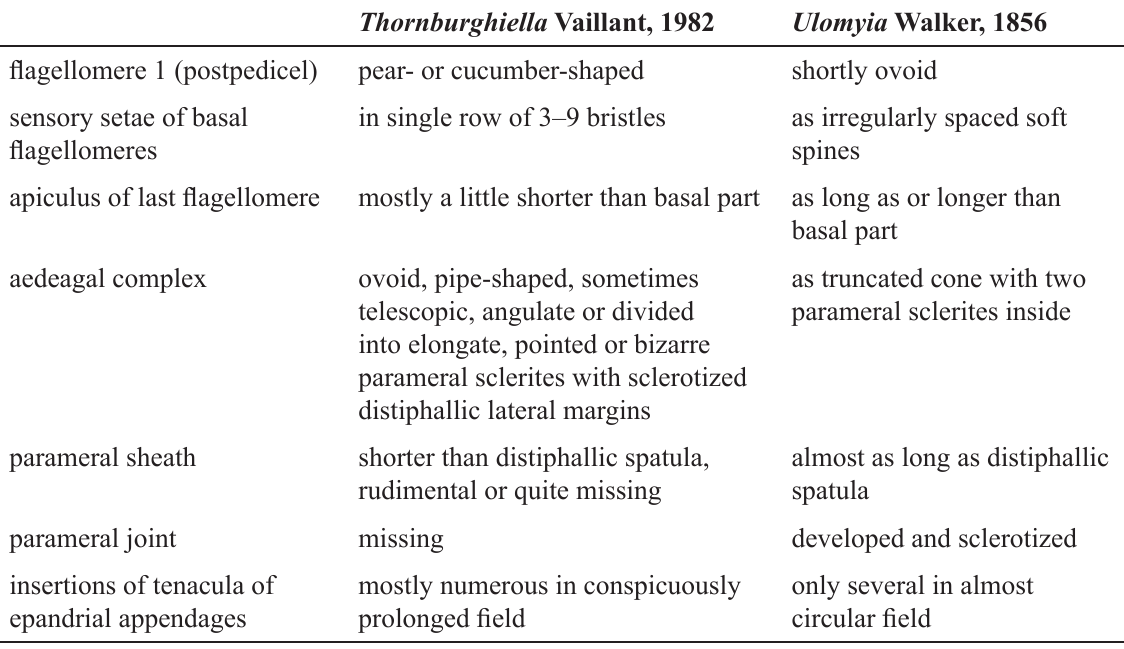
Table 1 . Morphological comparison of Thornburghiella Vaillant, 1982 and Ulomyia Walker, 1856 in the tribe Pericomaini Enderlein,